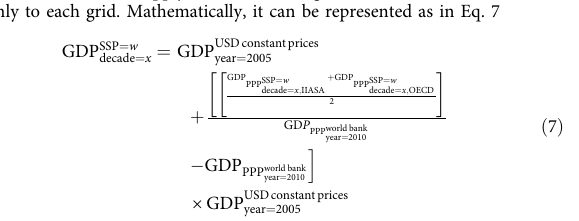
is the MISR-derived PM 2.5 for the baseline pentad ¼ bl is the CMIP5 model-derived PM 2.5 (as per Eq. pentad ¼ x is the CMIP5 model-derived PM 2.5 for pentad ¼ bl